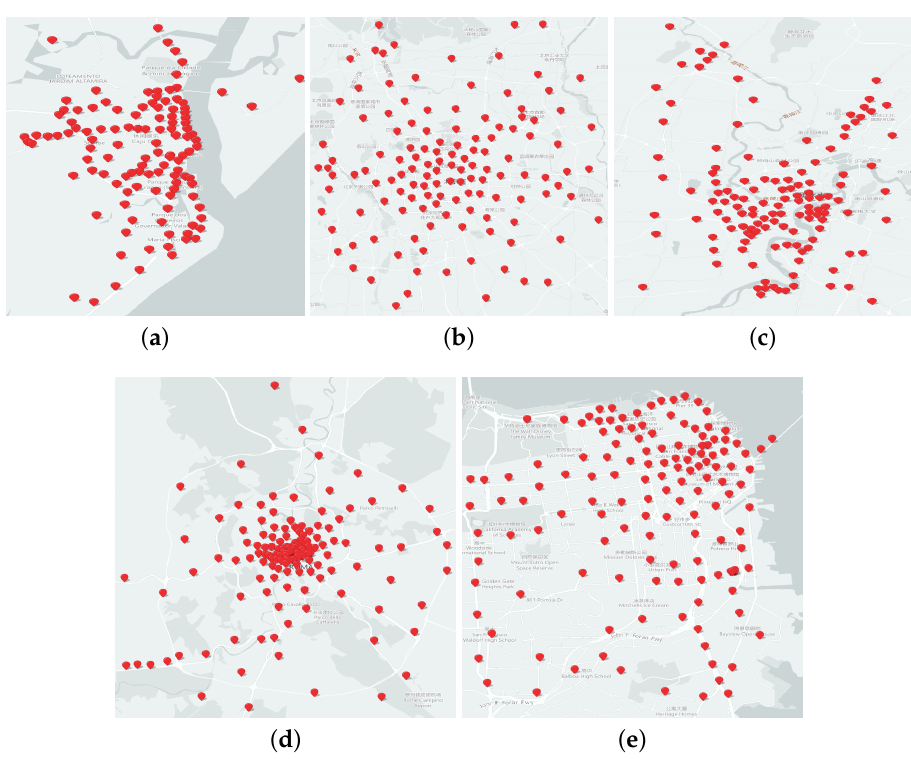
Figure 16. The urban hotspots captured by the PSOK algorithm. ( a ) Aracaju; ( b ) Beijing; ( c ) Chongqing; ( d ) Roma; ( e ) San Francisco.